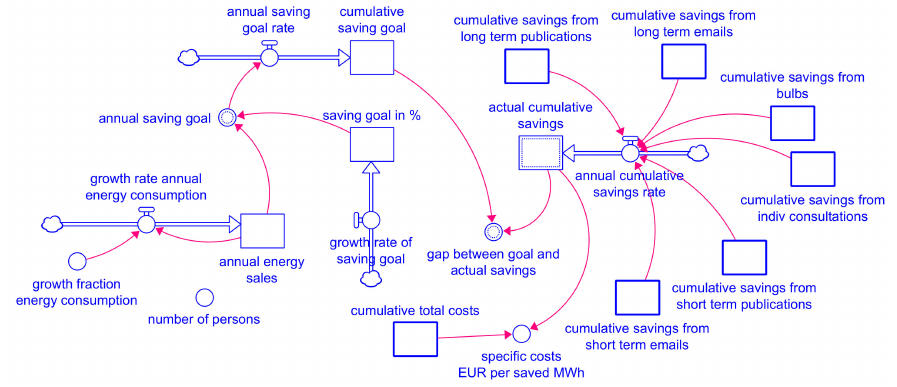
Figure 3. Stock and flow structure for the EEOS savings sub-module.